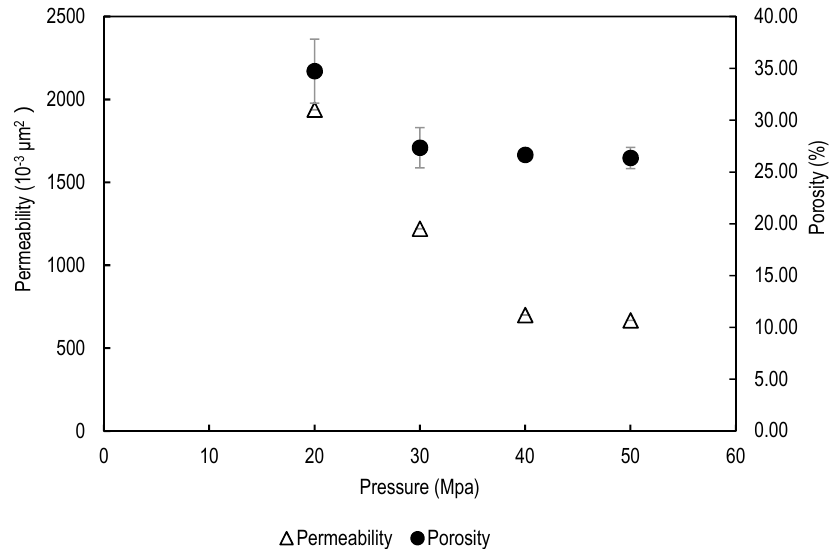
Figure 9. Permeability and porosity vs. pressure. Permeability curve is plotted with ∆ , and porosity curve is plotted with • .